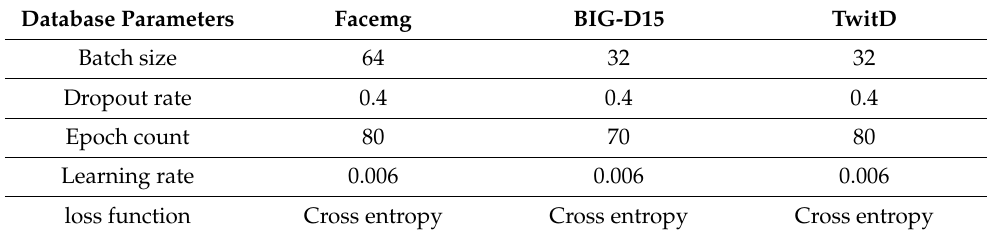
Table 4. Parameters of the Facemg, BIG-D15, and TwitD databases.